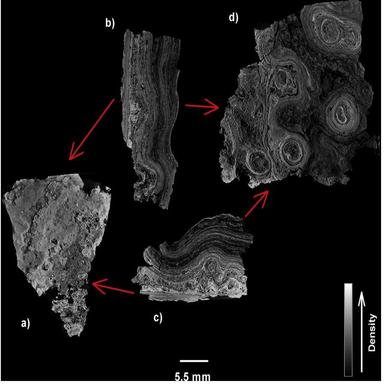
MicroCT slices of the steel pipe scale sample – a) coronal view (pipe wall side), b) sagittal view, c) transaxial view and d) coronal view (fluid flow side).